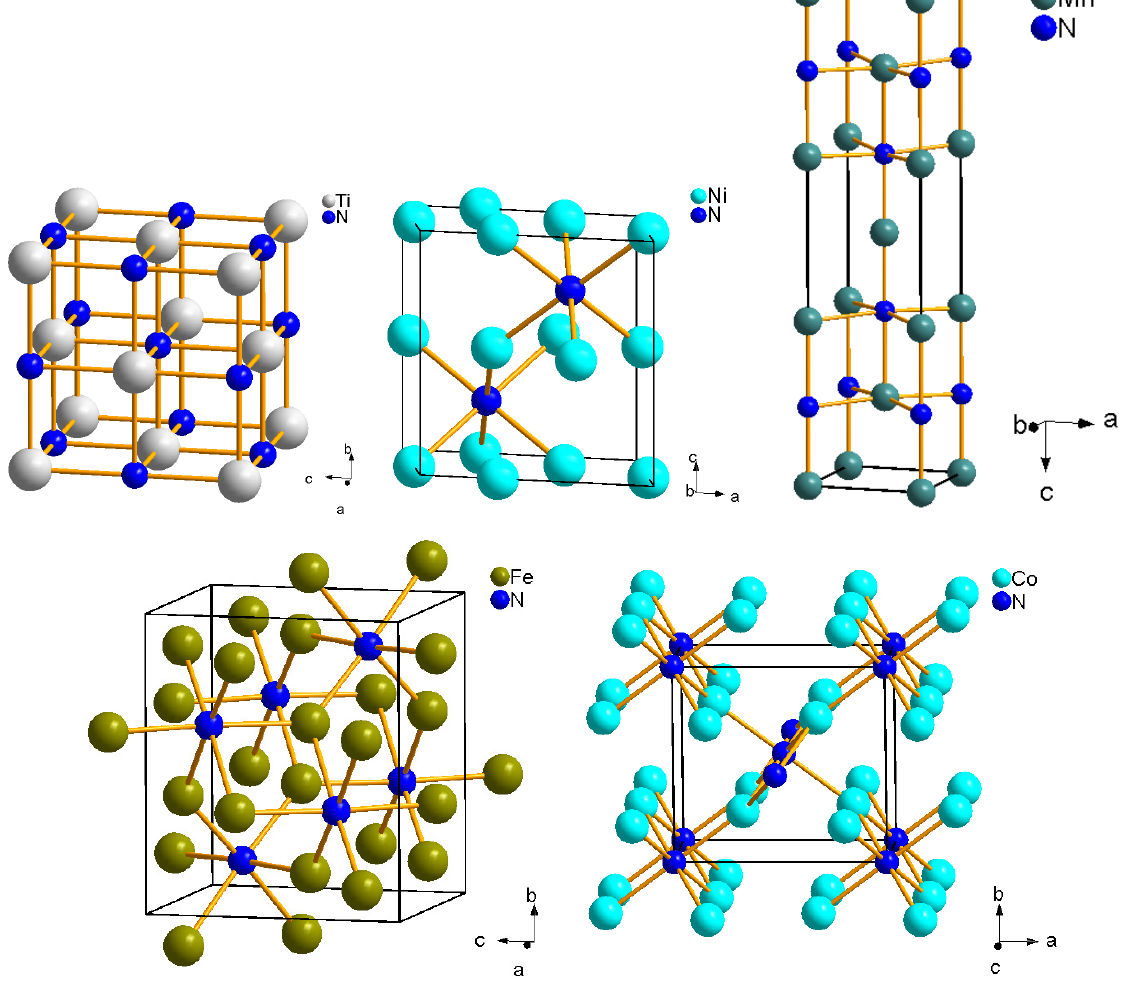
From top left to bottom right: Crystal structures of TiN (NaCl-type structure, N ( P 6 22), Mn N ( I 4/ mmm ), Fe 3 3 3 2